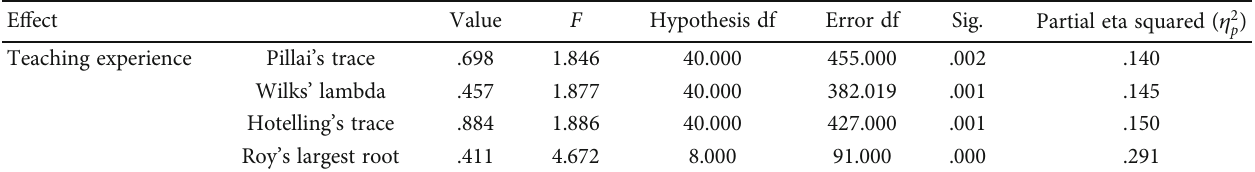
Table 4: MANOVA results of di ff erences in multiple intelligences based on teaching experience. E ff